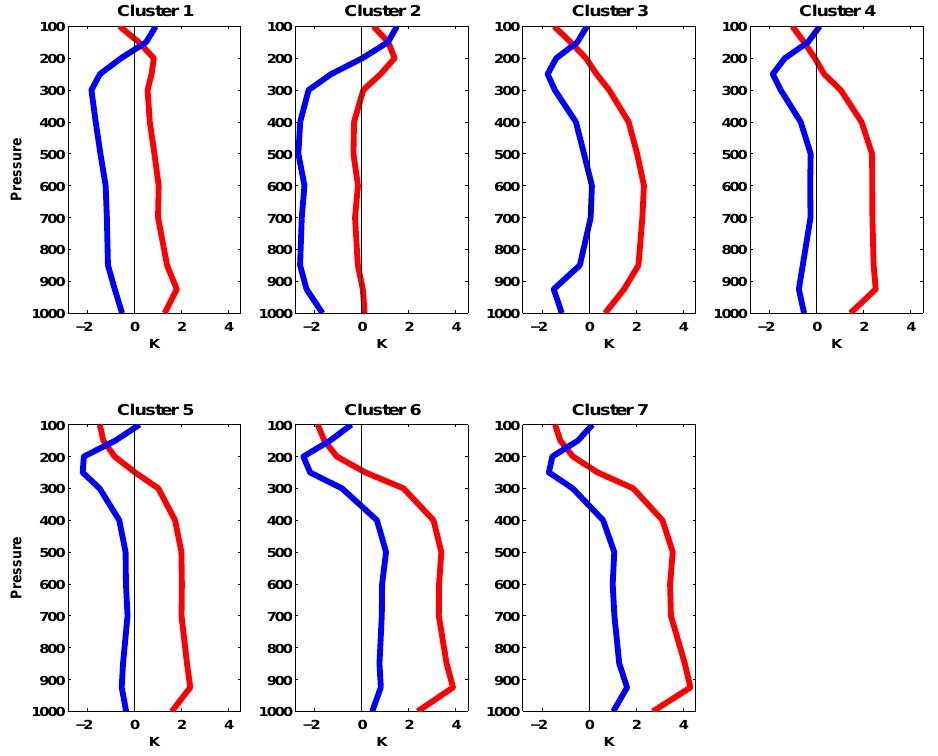
Fig. 14. Vertical profiles of temperature anomalies for warm (red) and cold (blue) subsets for each cluster from the NCEP reanalysis.